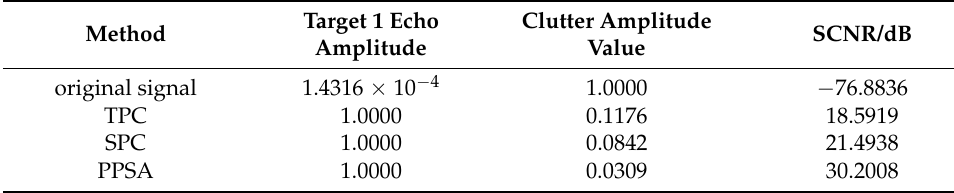
Table 9. SCNR comparison of target 1.